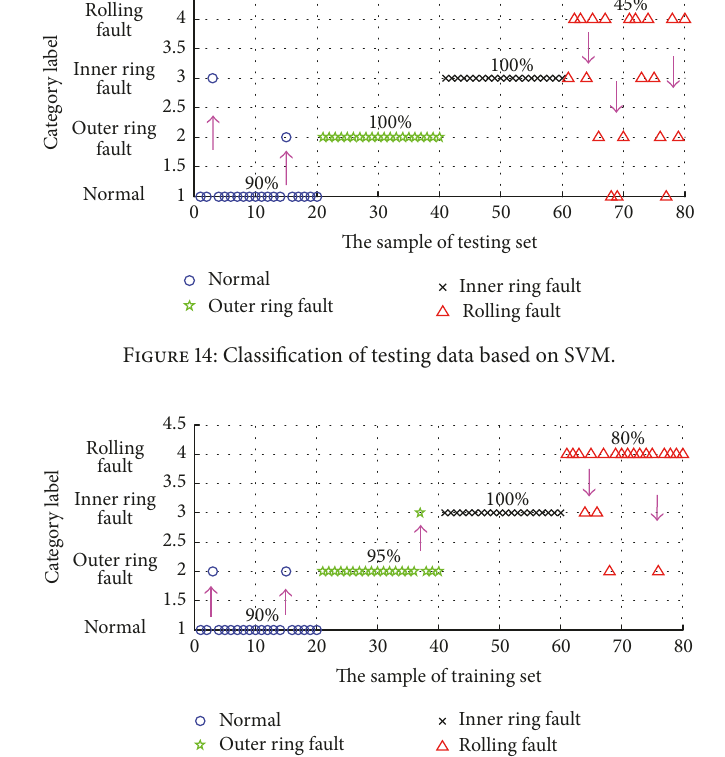
Figure 15: Classification of testing data based on